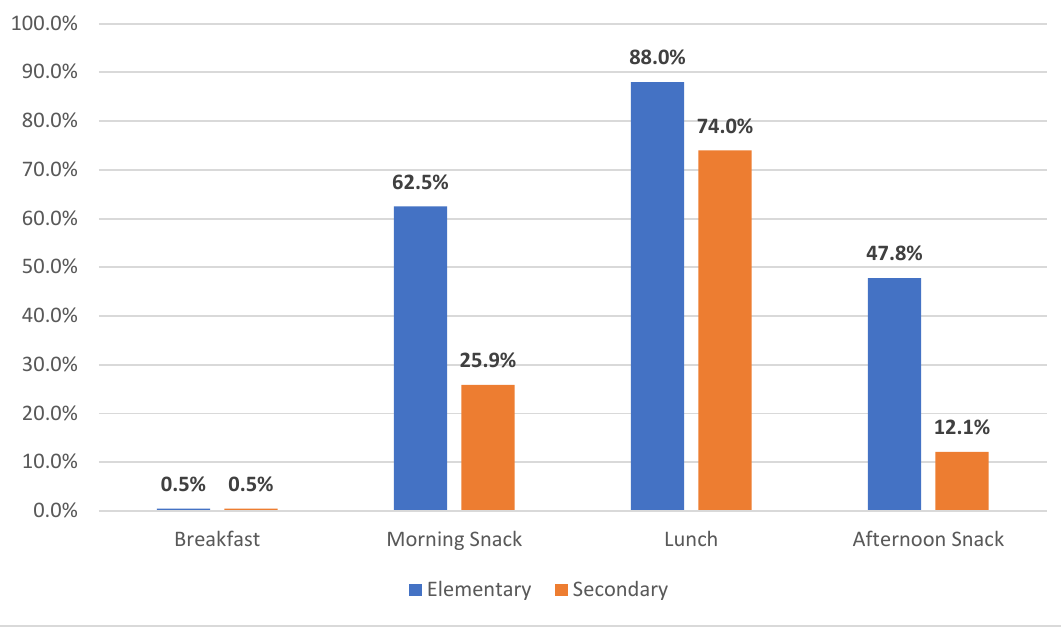
Figure 1. Proportion of elementary and secondary students eating snacks/meals at school on the day of the 24-h diet recall. Table 2. Frequency of elementary and secondary students eating meals or snacks prepared away from